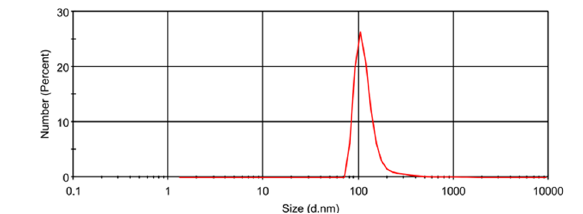
Figure 5: Overlaid contour plot of colour intensity, particle size with acceptable levels as function of amount of Na Aloe vera leaf extract.